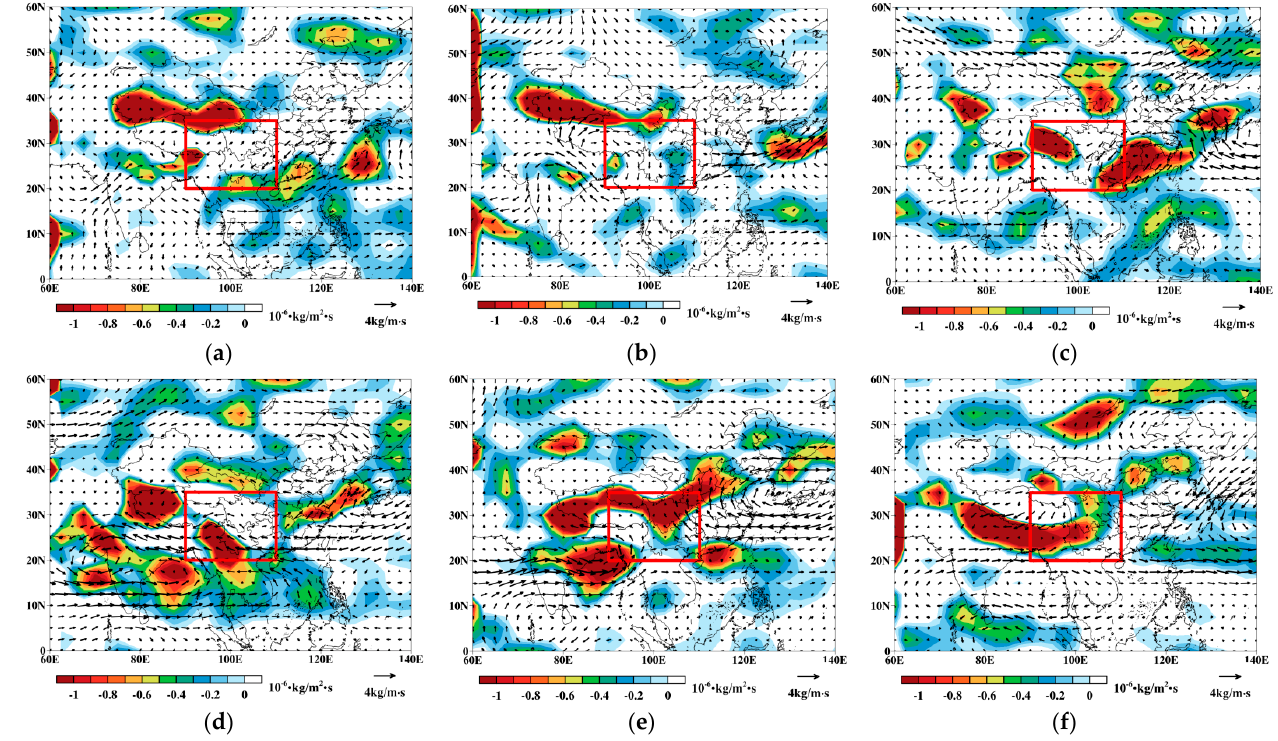
Figure 20. Homochronous whole-layer water vapor flux integral and water vapor divergence in the first cycle of 30–60 days ISO in 1998. (Unit of water vapor flux integral: kg · m − 1 · s − 1 ; unit